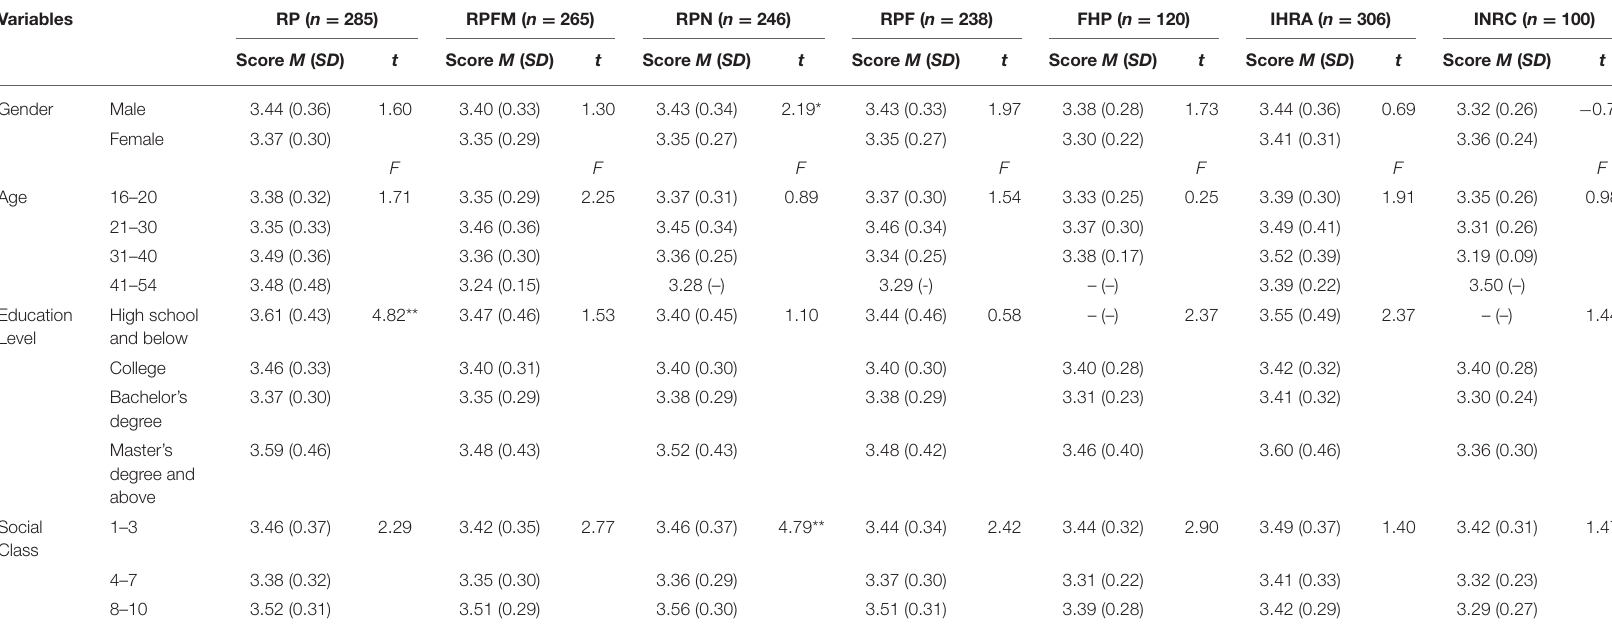
TABLE 8 | The differences between main variables regarding different individuals-related stigma toward COVID-19.